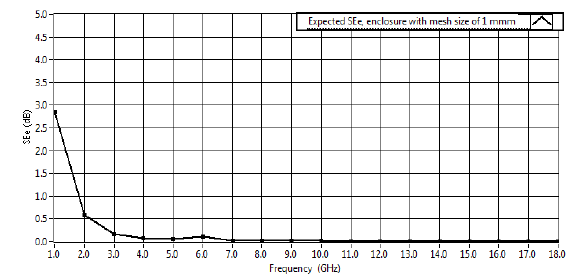
Figure 11: Expected SE e for the enclosure with mesh size of 1